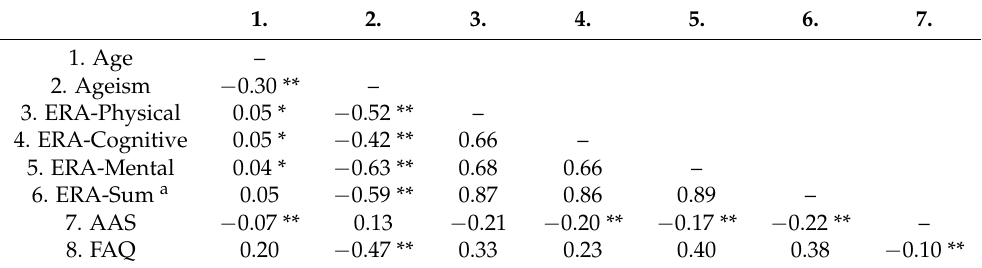
Table 3. Relationships amongst the observed study variables using Spearman correlation coefficients.